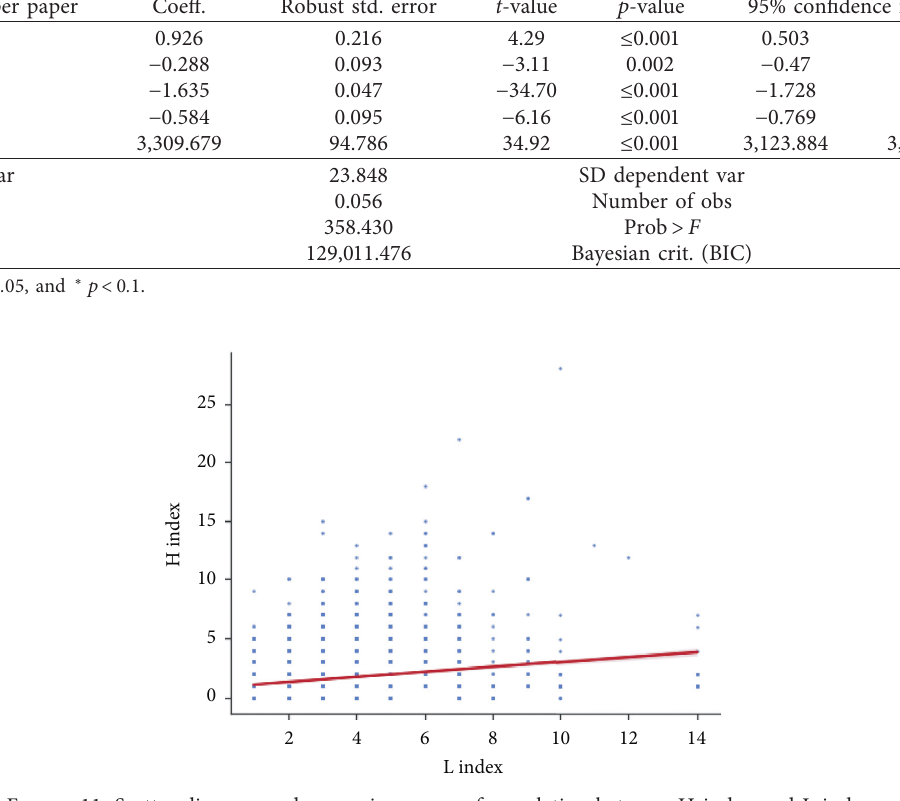
Figure 11: Scatter diagram and regression curve of correlation between H-index and L-index. Table 7: Unary linear regression results of H-index and